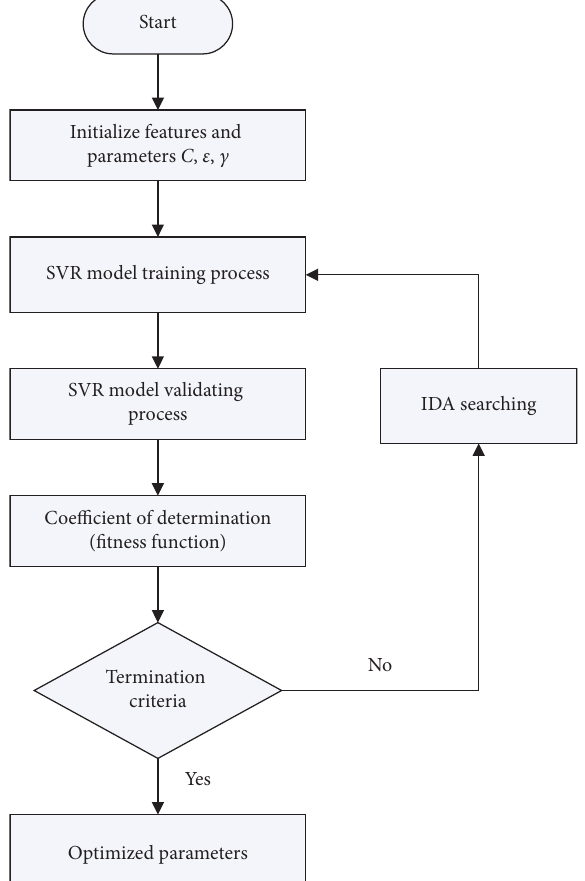
Figure 3: Flowchart of the IDA-SVR